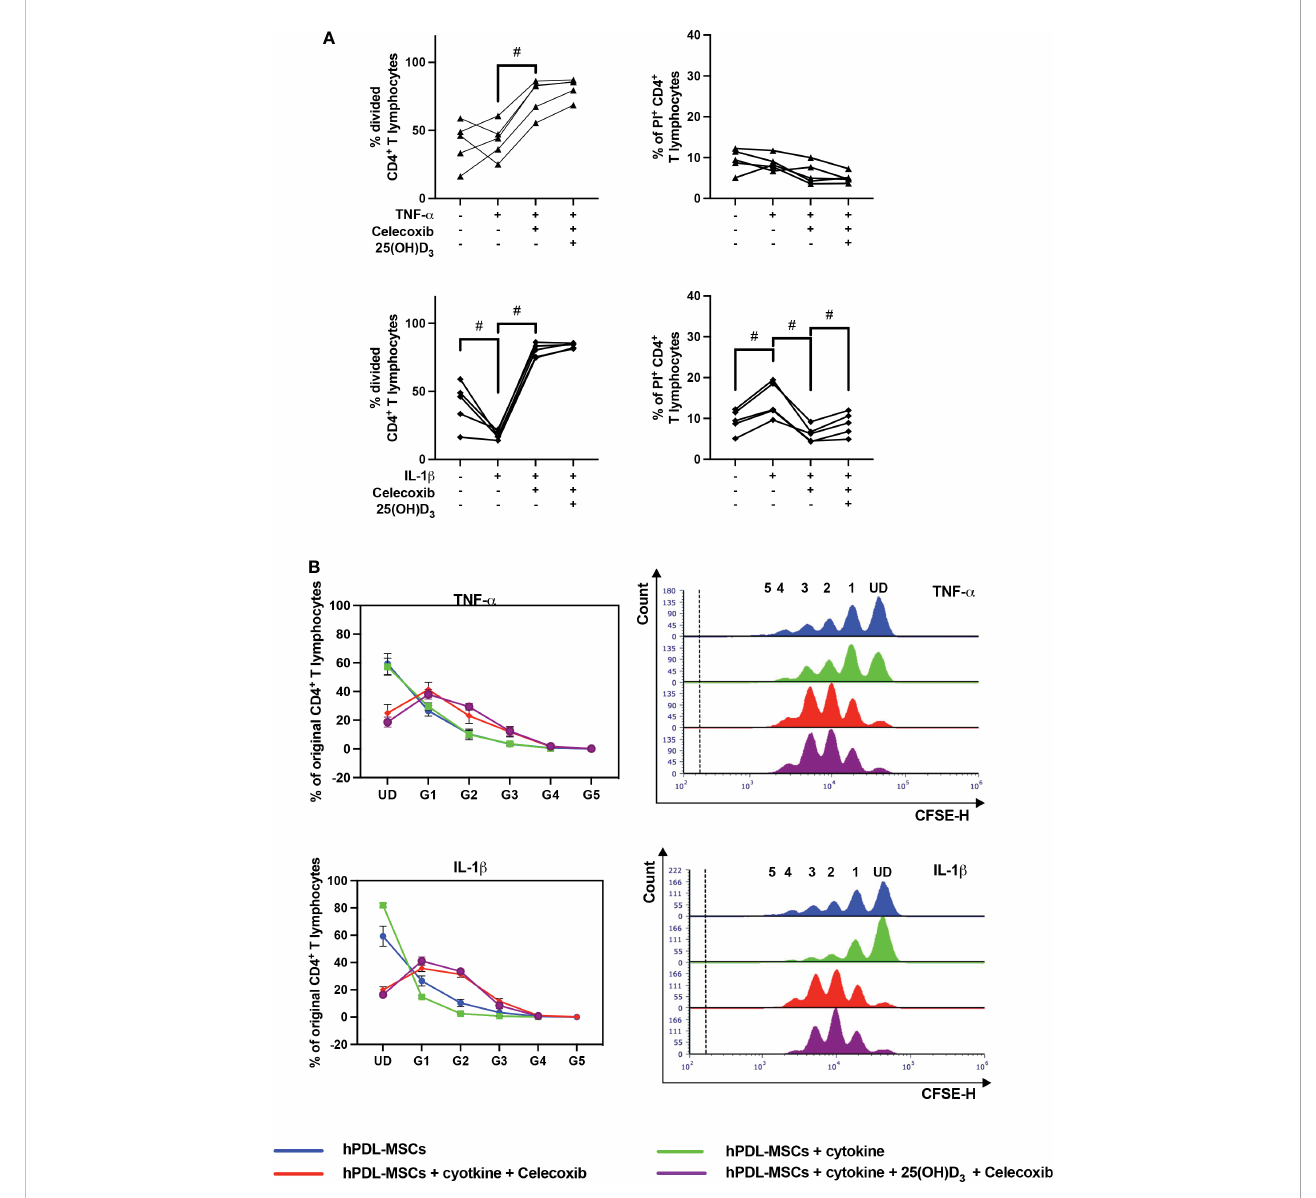
FIGURE 8 In fl uence of PTGS-2 pharmacological inhibition on the CD4 + T lymphocyte proliferation and viability in the presence of hPDL-MSCs under different cytokine conditions. After fi ve days of indirect co-culture with hPDL-MSCs, fl ow cytometry analysis was used to determine the proliferation and viability of CD4 + T lymphocytes by CFSE and PI staining, respectively. (A) reveals the percentage of original CD4 + T lymphocytes that have divided and the percentage of PI + CD4 + T Lymphocytes, whereas (B) shows the number of original CD4 + T lymphocytes as a percent of the total number of original cells for each single cell generation (UD = undivided; G1-G5 = generation 1 – generation 5). Additionally, representative histograms show the number of CD4 + T lymphocytes for all generations (UD and 1-5). Data were obtained from fi ve (A, B) experimental repetitions using hPDL-MSCs from a different individual per repetition. One technical replicate was used per experimental group. In (A) , each experimental repetition is represented as an individual line. The percentage of original CD4 + T lymphocytes in (B) are presented as mean ± S.E.M. The Friedman test, followed by the Wilcoxon test, was used for pairwise comparison (A) . # p-value < 0.05 were considered to be statistically signi fi cant between groups as